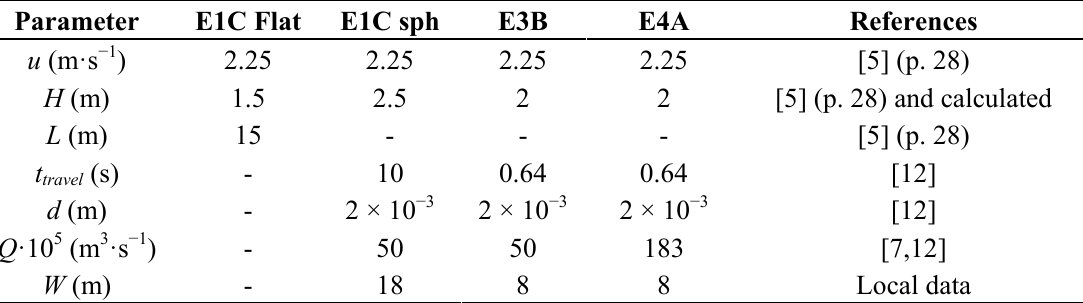
Table 5. Volatilization parameters for outdoor